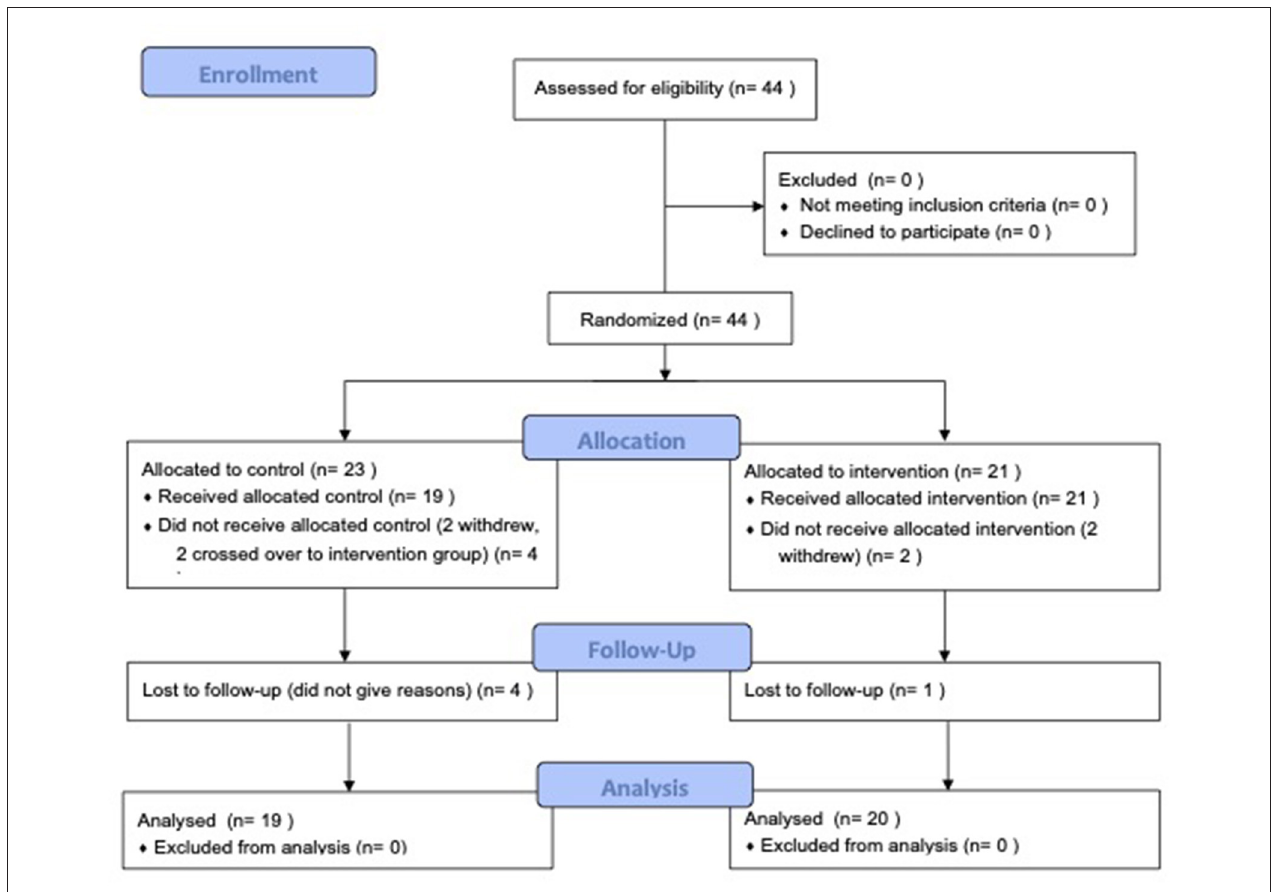
FIGURE 1 | CONSORT flow